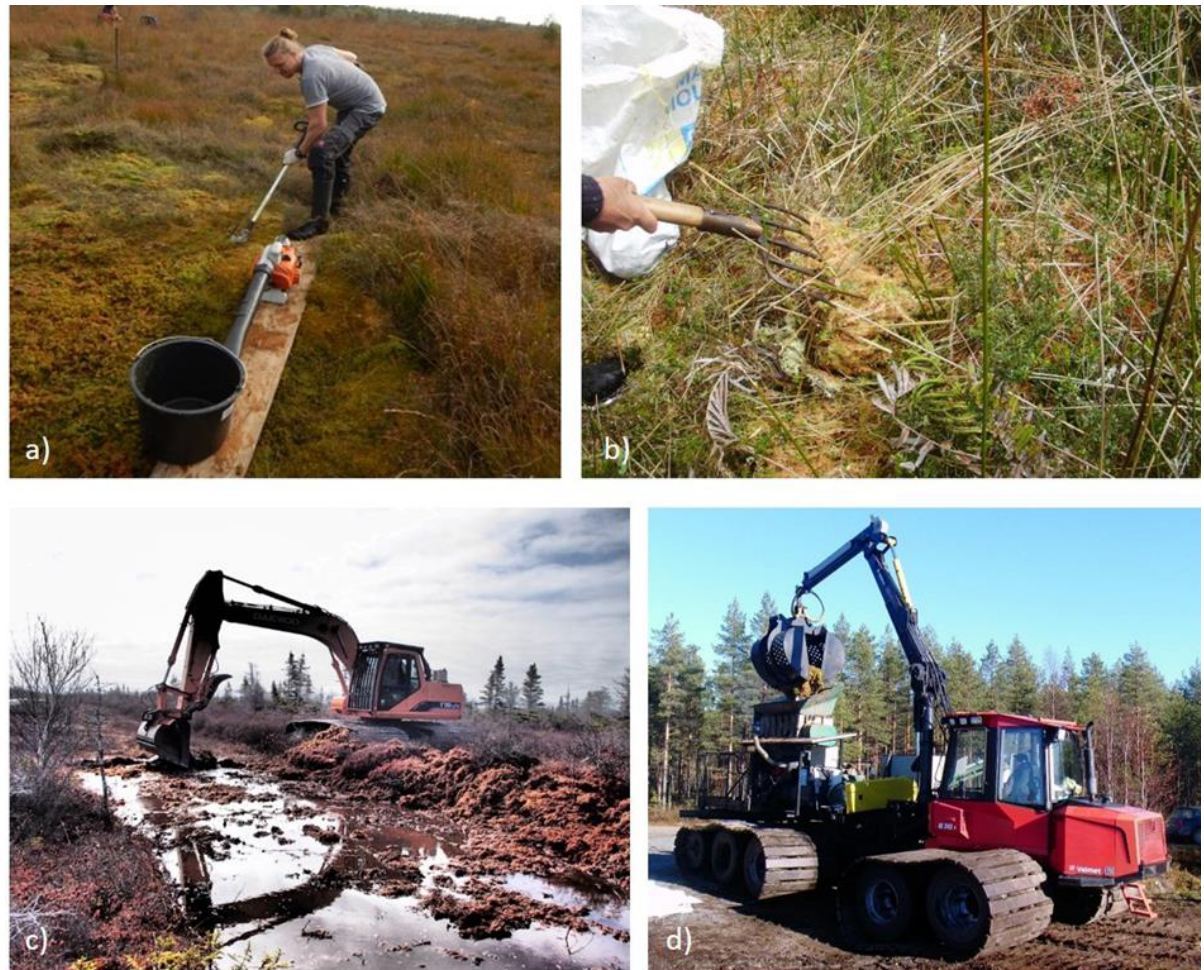
Figure 1. Manual (a, b) and mechanical (c, d) Sphagnum gathering from wild populations, for founder material in Germany (a) and Canada (c) or commercial use in Chile (b) and Finland (d). In (a) only the upper 5 cm of half a Sphagnum hummock was cut to favour regrowth. Photos: a) Jan Köbbing, b) Christel Oberpaur, c) Peatland Ecology Research Group and d) Matthias